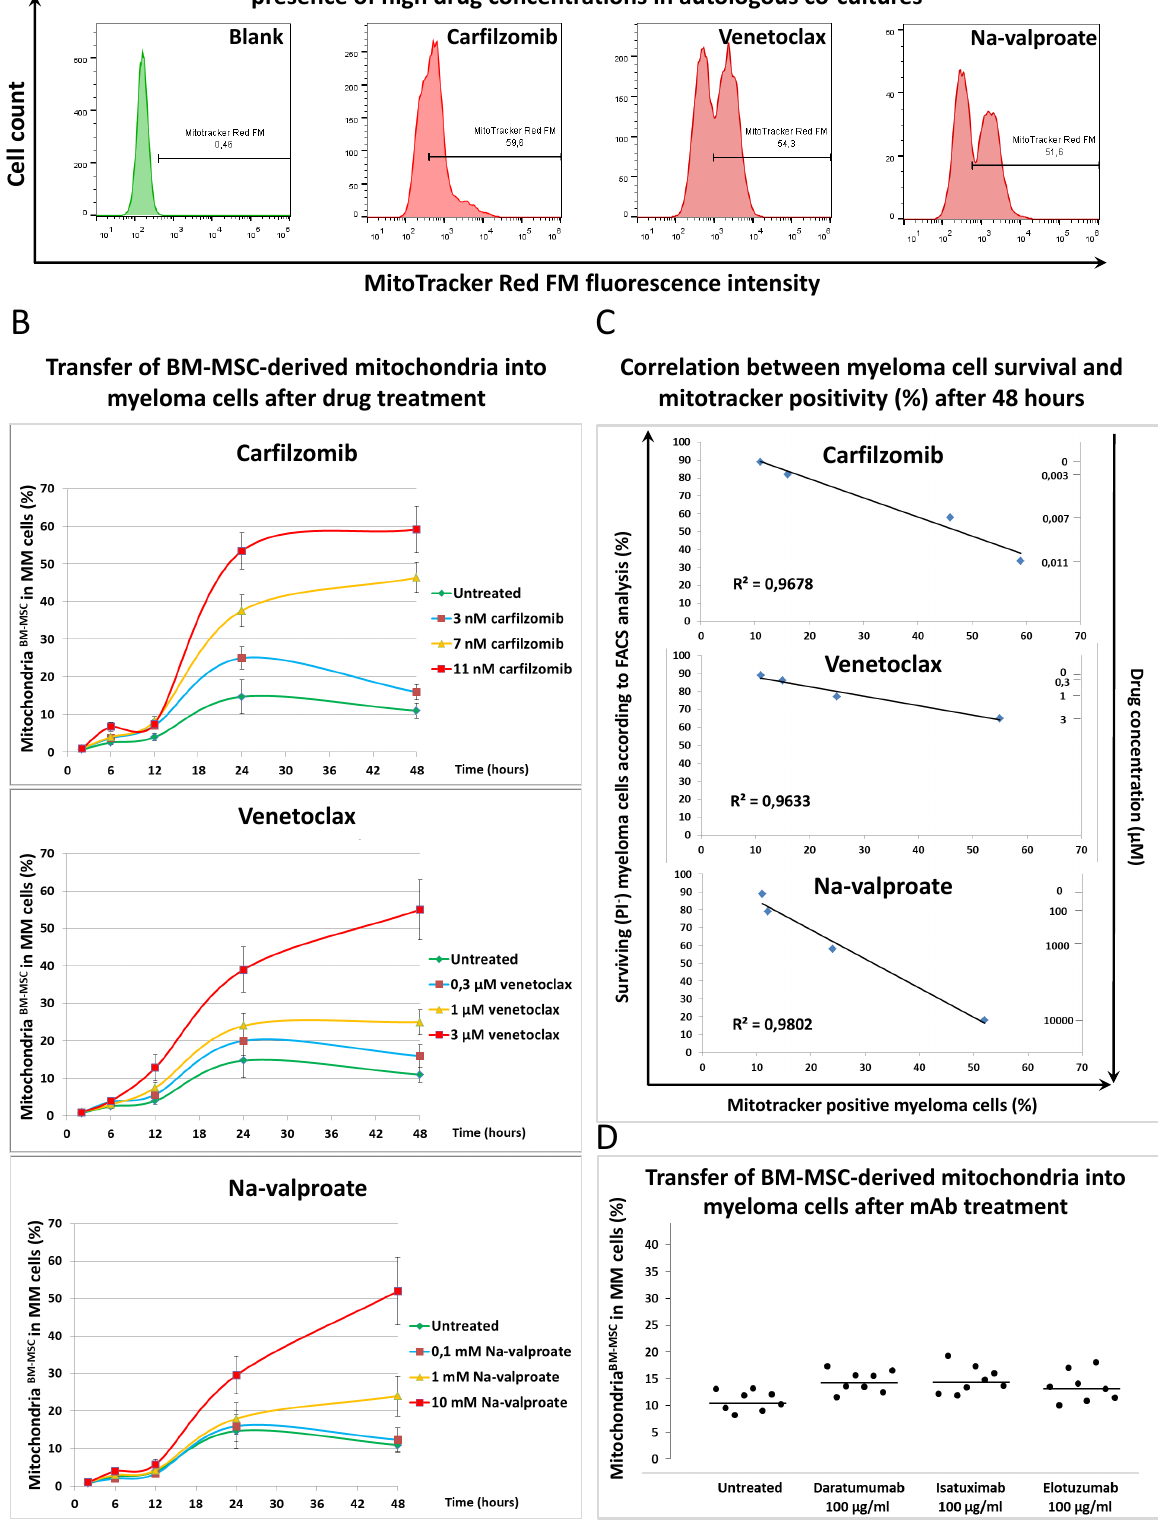
Figure 2. Mitochondrial transfer from bone marrow stromal cells to myeloma cells in the presence of chemotherapeutic drugs and therapeutic antibodies. ( A ) BM-MSCs were labeled with Mitotracker Red FM then co-cultured with MMs for 48 h in the presence or absence of the highest concentrations of each drug: 3 µ M of venetoclax, 10 mM of Na-valproate, and 11 nM of carfilzomib. BM-MSC-derived mitochondria + MMs were analyzed by flow cytometry within the CD38 +